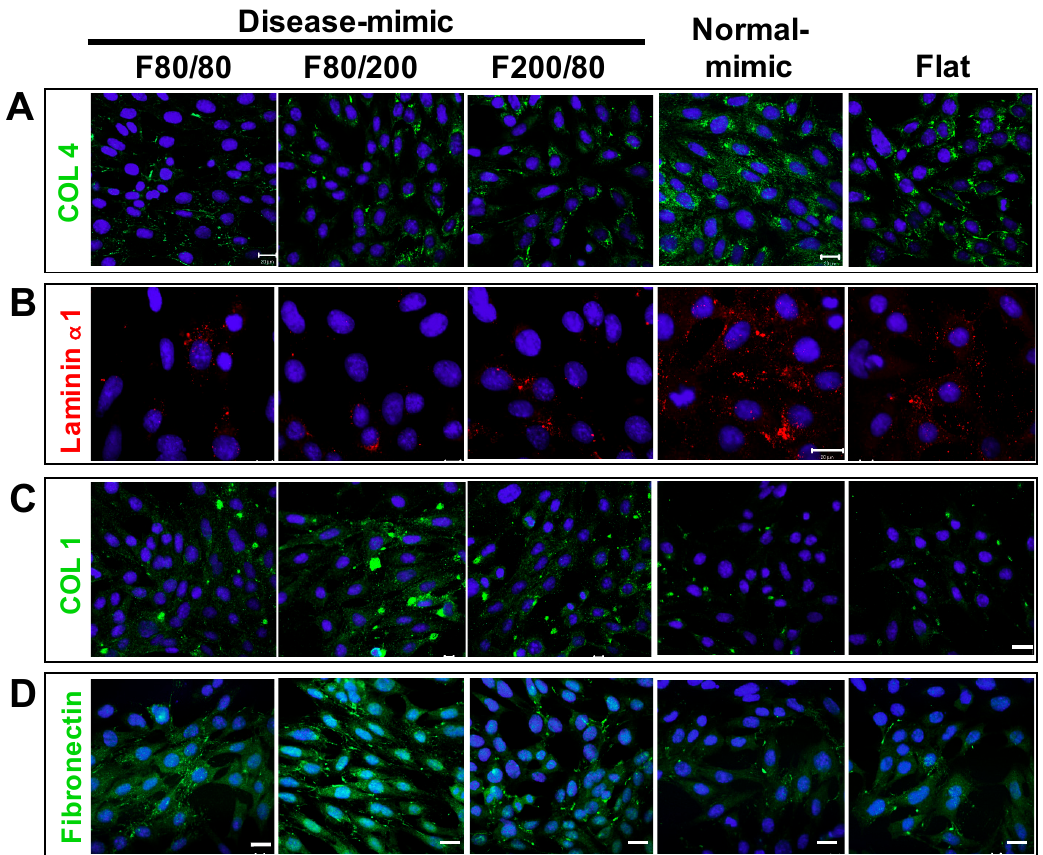
Figure 3. Expressions of extracellular matrix (ECM) components in MES13 cells cultured on disease- and normal-mimic nanopatterns. Cells were cultured on various TiO 2 nanopatterns for 48 h and immunostained for the following ECM components: Type IV collagen ( A , COL4, green), laminin α 1 ( B , red), type I collagen ( C , COL1, green) and fibronectin ( D , green). The nuclei were stained with 4 ′ ,6-diamidino-2-phenylindole (DAPI) (blue), and the fluorescence images were taken with a confocal microscope. Scale bar = 20 μ m.